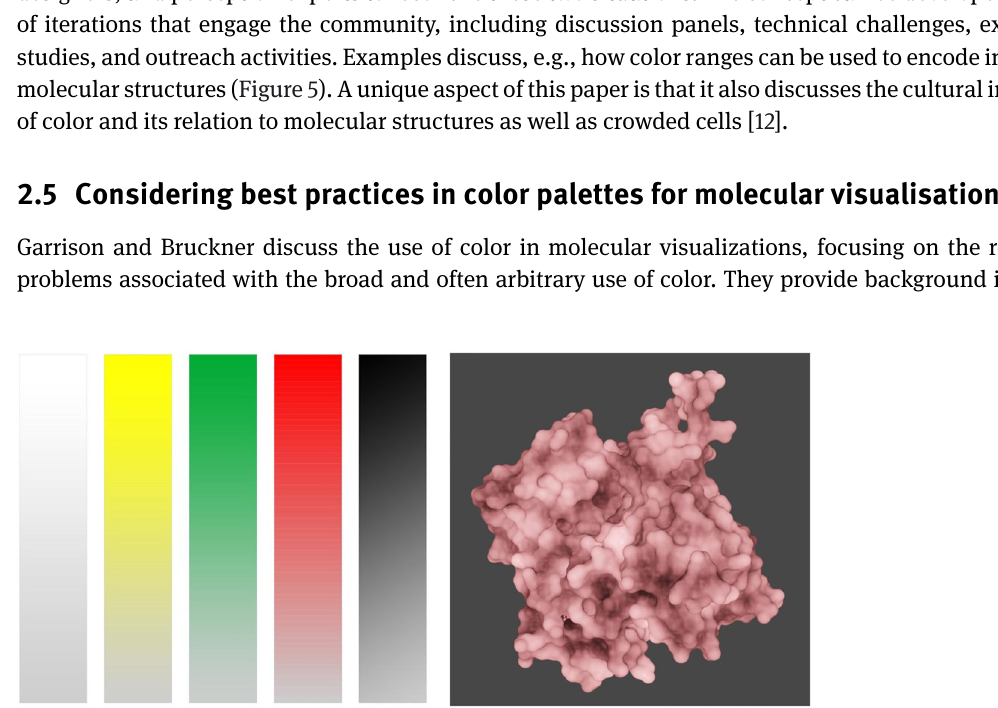
Figure 5: Colors in the representation of biological structures: molecular structures and their intensity – each color can have a range of intensity (left), which can be used to represent properties expressed by a continuum (right), here: an actin monomer ( © 2022 Zoppè et al., CC BY 4.0